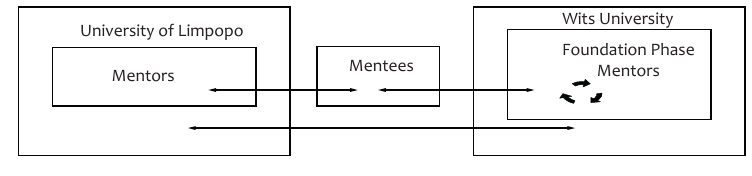
Figure 1: A multidimensional mentoring